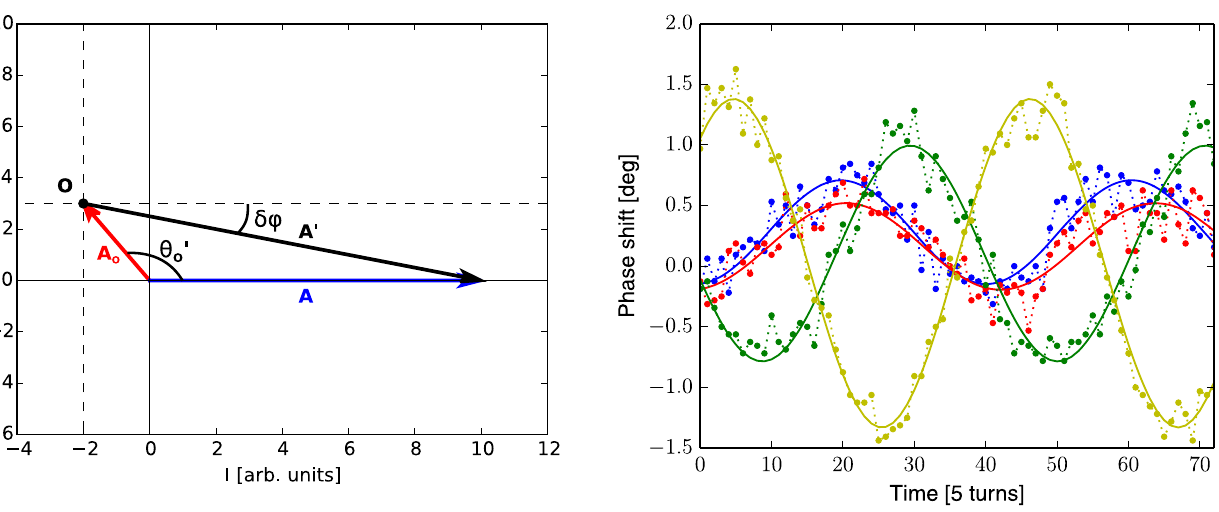
FIG. 9. Sine-wave fit (solid lines) of the synchrotron oscil- lations measured for four different bunches (dots) used in the data post-processing.